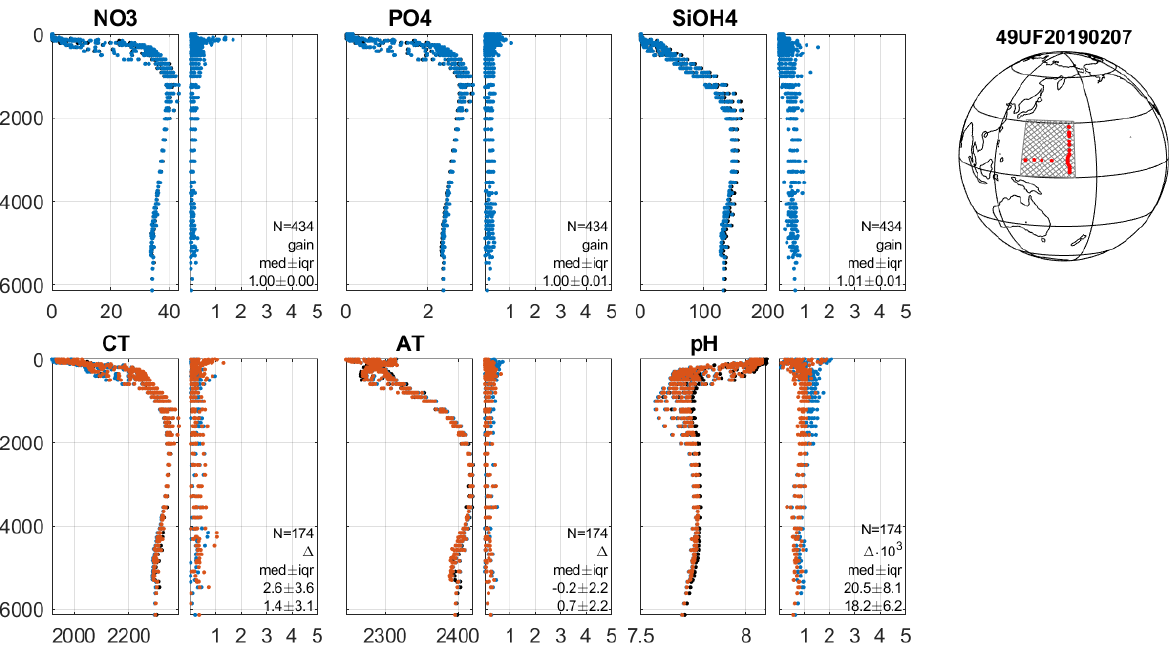
Figure 5. Example summary figure for CANYON-B and CONTENT analyses for 49UF20190207. Any data from regions where CONTENT and CANYON-B were not trained are excluded. The top row shows the nutrients and the bottom row the seawater CO 2 chemistry variables. All are shown versus sampling pressure (dbar), and the unit is micromoles per kilogram (µmolkg − 1 ) for all except pH, which is on the total scale at in situ temperature and pressure. Black dots (which to a large extent are hidden by the predicted estimates) are the measured data, blue dots are CANYON-B estimates, and red dots are the CONTENT estimates. Each variable has two figure panels. The left shows the depth profile, while the right shows the absolute difference between measured and estimated values divided by the CANYON-B and CONTENT uncertainty estimate, which is determined for each estimated value. These values are used to gauge the comparability; a value below 1 indicates a good match, as it means that the difference between measured and estimated values is less than the uncertainty of the latter. The statistics in each panel are for all data deeper than 500dbar, and N is the number of samples considered. A multiplicative adjustment and its interquartile range are given for the nutrients. For the seawater CO 2 chemistry variables the numbers in each panel are the median difference between measured and predicted values for CANYON-B (upper) and CONTENT (lower). Both are given with their interquartile range.